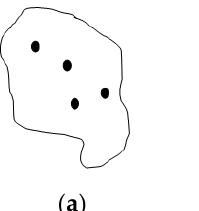
Figure 1. ( a ) Non-rectangular and ( b ) Rectangular regions of interest.